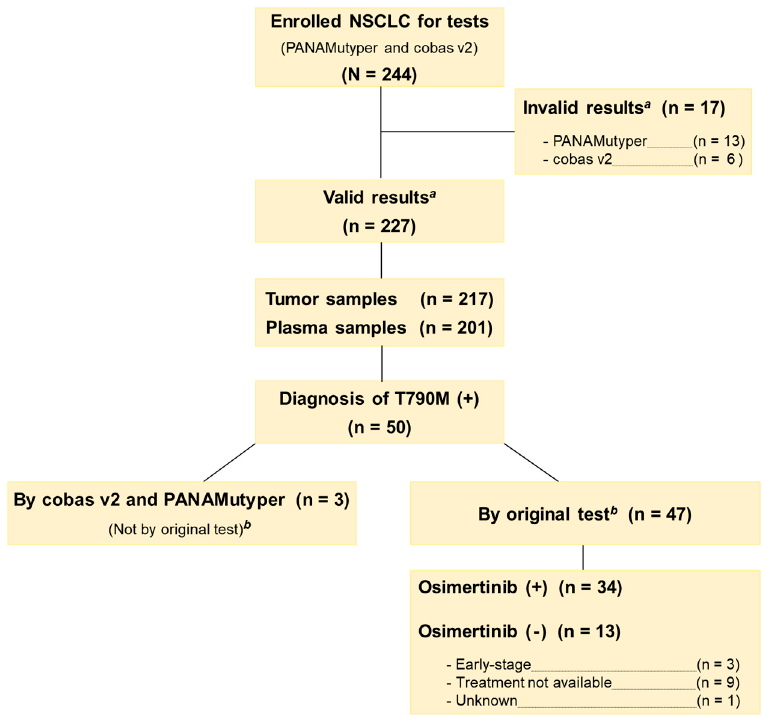
Figure 1. Consort diagram and study flowchart. a Tests were considered valid only if samples failed to pass qualitative and quantitative quality control. b Original test was peptic nucleic acid (PNA) clamping test. Table 1. Characteristics of patients (n = 227) with valid EGFR test results using two mutation tests. Patient Demographics (Wild vs. Mutant)